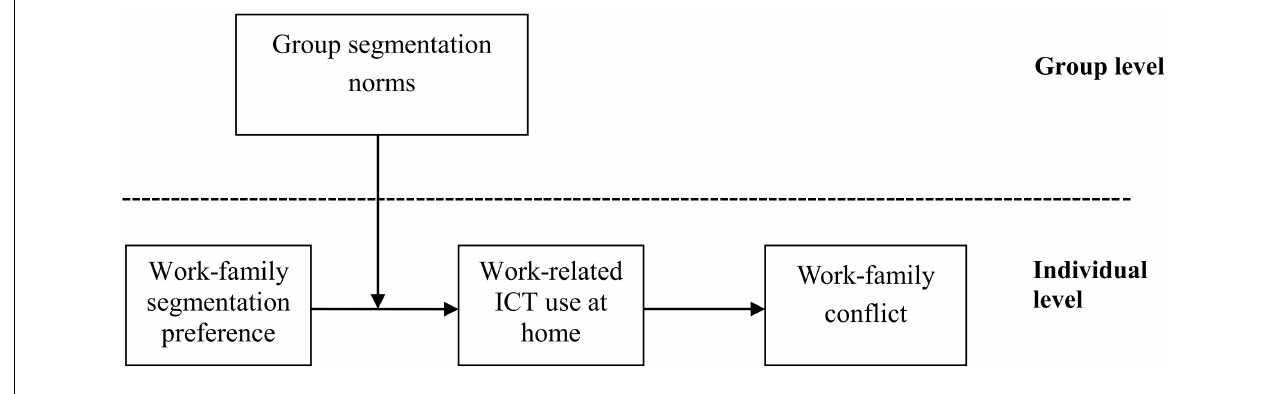
FIGURE 1 | Proposed